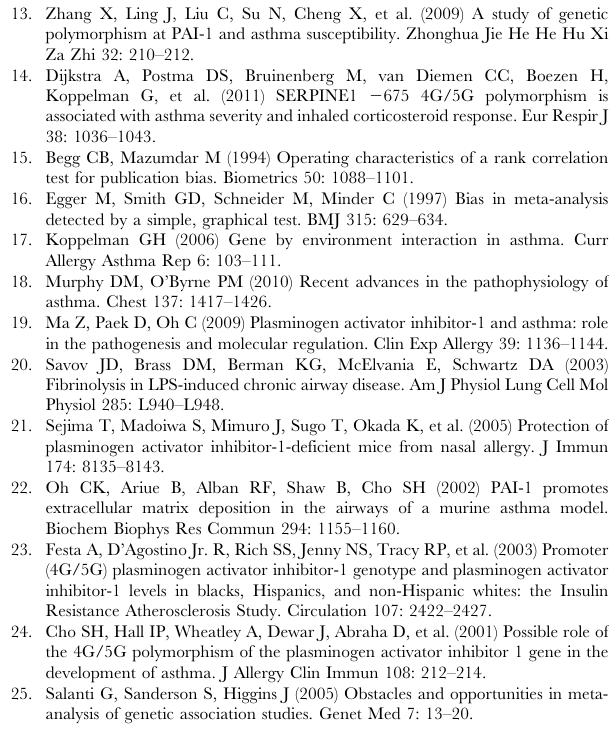
Table S3 Summary of different comparative